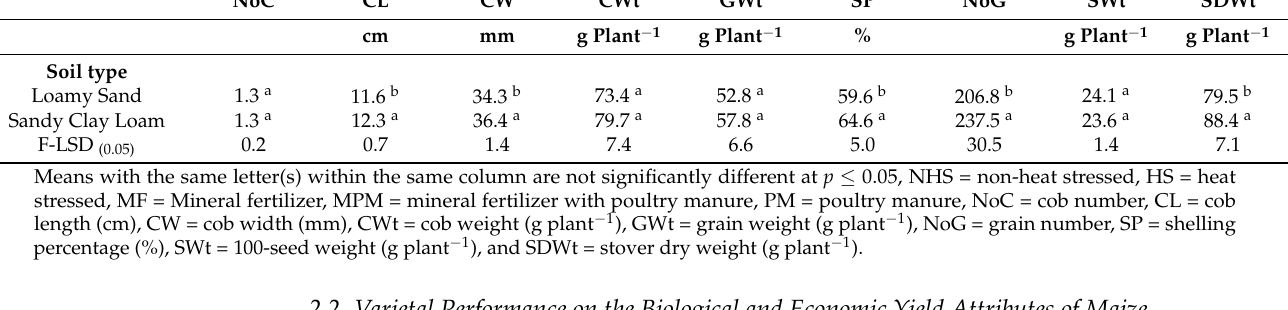
Figure 2. The discriminating and representative abilities of the maize yield attributes on the maize varieties (NOC = cob number, CL = cob length (cm), CW = cob width (mm), GCWT = cob weight (g plant − 1 ), GWT = grain weight (g plant − 1 ), NOG = grain number, SP = shelling percentage (%), SWT = 100 ‐ seed weight (g plant − 1 ), and SDWT = stover dry weight (g plant − 1 )). 2.3. Effects of Soil Amendment on the Maize Biological and Economic Yield Attributes Excluding the SP, soil amendment significantly ( p < 0.05) influenced the maize yield attributes in this study. The complementary (50:50) application of poultry manure and mineral fertilizer (MPM) produced the highest NoC, CW, and SWt, which were signifi ‐ cantly higher than the other soil amendments (Table 1). It was statistically similar to the poultry manure (PM) amendment in the CL, CWt, GWt, NoG, and SDWt. Mineral ferti ‐ lizer (MF) was significantly lower than the other amendments in the aforementioned yield attributes.